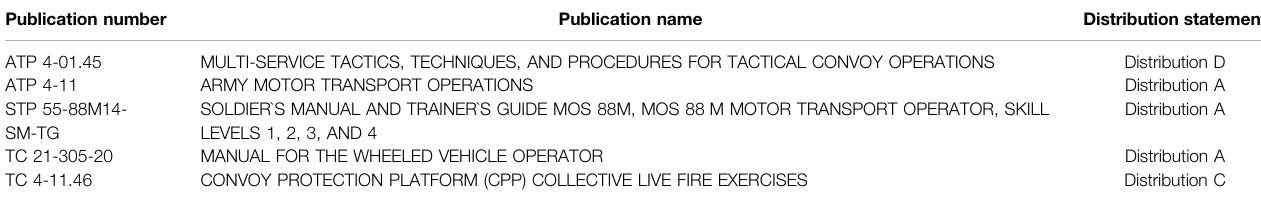
TABLE 1 | Current Army publications relevant to convoy